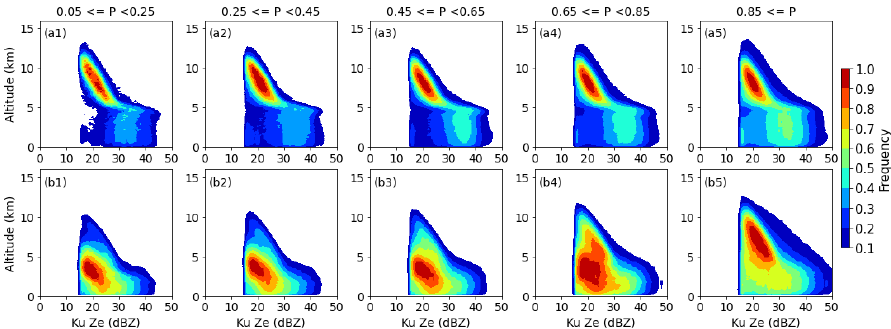
Figure 4. Contoured frequency by altitude diagram, showing the frequency normalized by the maximum bin of radar reflectivity. Data were binned at 1dBZ intervals at each level. The upper panels are for the tropics (within 25 ◦ latitude), and the lower panels are for the midlatitudes (between 25 and 60 ◦ latitude).